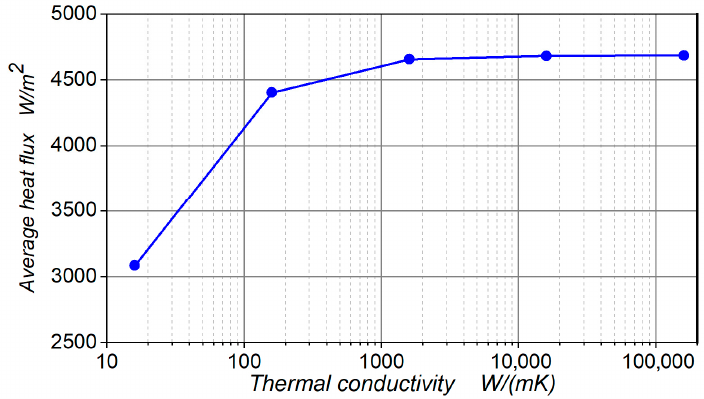
Figure 8. Heat flux versus fin thermal conductivity.